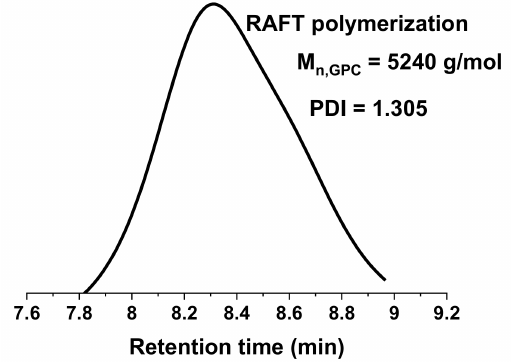
Figure 3. GPC elution profile of pCT synthesized by RAFT